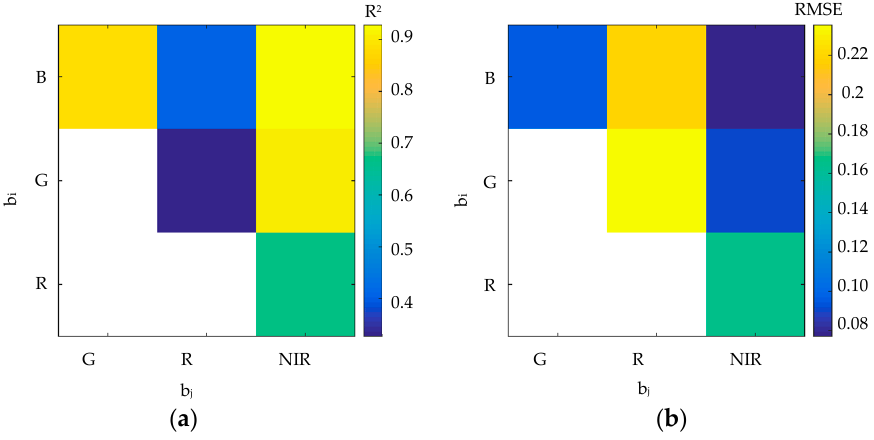
Figure 13. OBA-NDWI for the synthetic GeoEye spectra; all possible combinations of spectral bands are considered in the structure of NDWI to perform a second order regression against water fractions. Values of ( a ) R 2 and ( b ) RMSE are represented by the color bars.